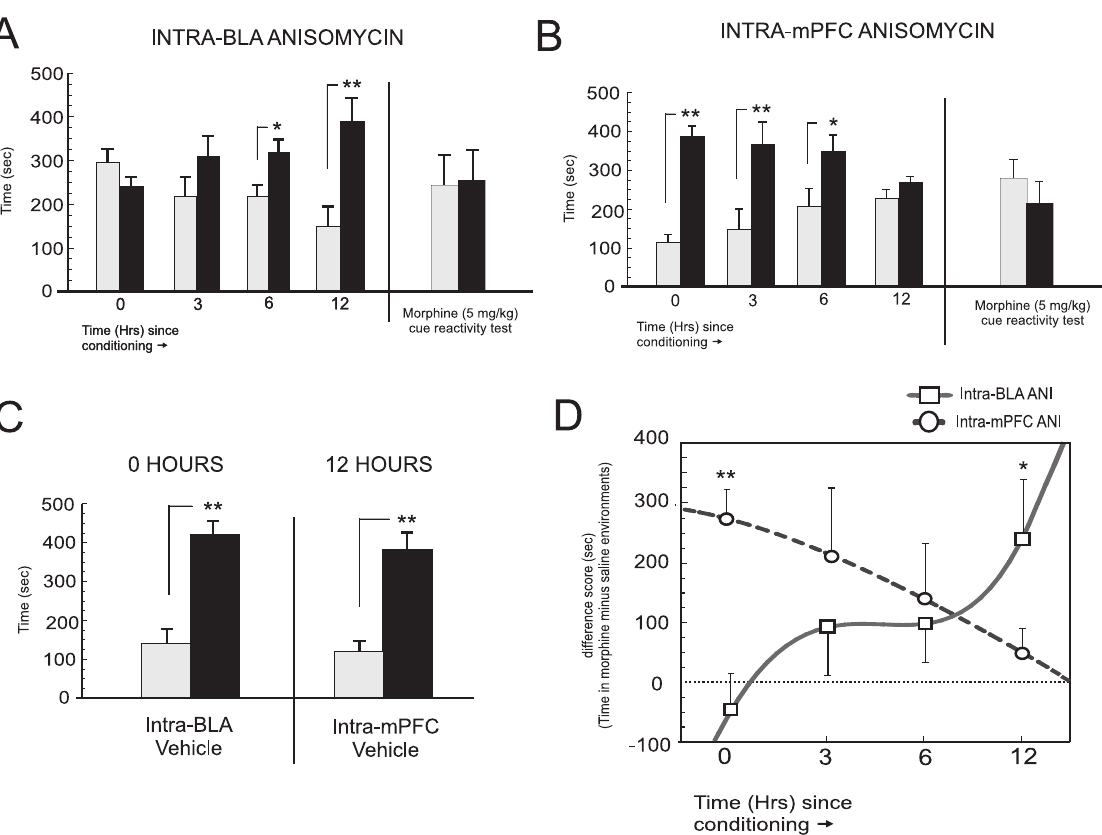
Figure 2. Effects of intra-BLA or mPFC anisomycin on temporal consolidation of acute opiate reward memory. A , Post-conditioning intra-BLA microinfusions of ANI completely block consolidation of opiate reward memory when administered at 0 and 3 hrs, but has no effect at 6 or 12 hrs. A Morphine cue-recall control test administered 24 hrs after the initial CPP test in the 0 hr group does not re-store the memory. B , Post- conditioning intra-mPFC microinfusions of ANI completely block consolidation of opiate reward memory when administered at 12 hrs, but has no effect at time-points before this. A morphine cue-recall control test administered 24 hrs after the initial CPP test in the 12 hr group does not re-store the memory. C , Vehicle control groups for the effective time points of 0 hrs (intra-BLA) or 12 hrs (intra-mPFC) caused no block of morphine reward CPP memory consolidation. D, Temporally divergent effects of opiate reward memory consolidation interference presented as CPP difference scores (calculated as times in drug minus vehicle-paired